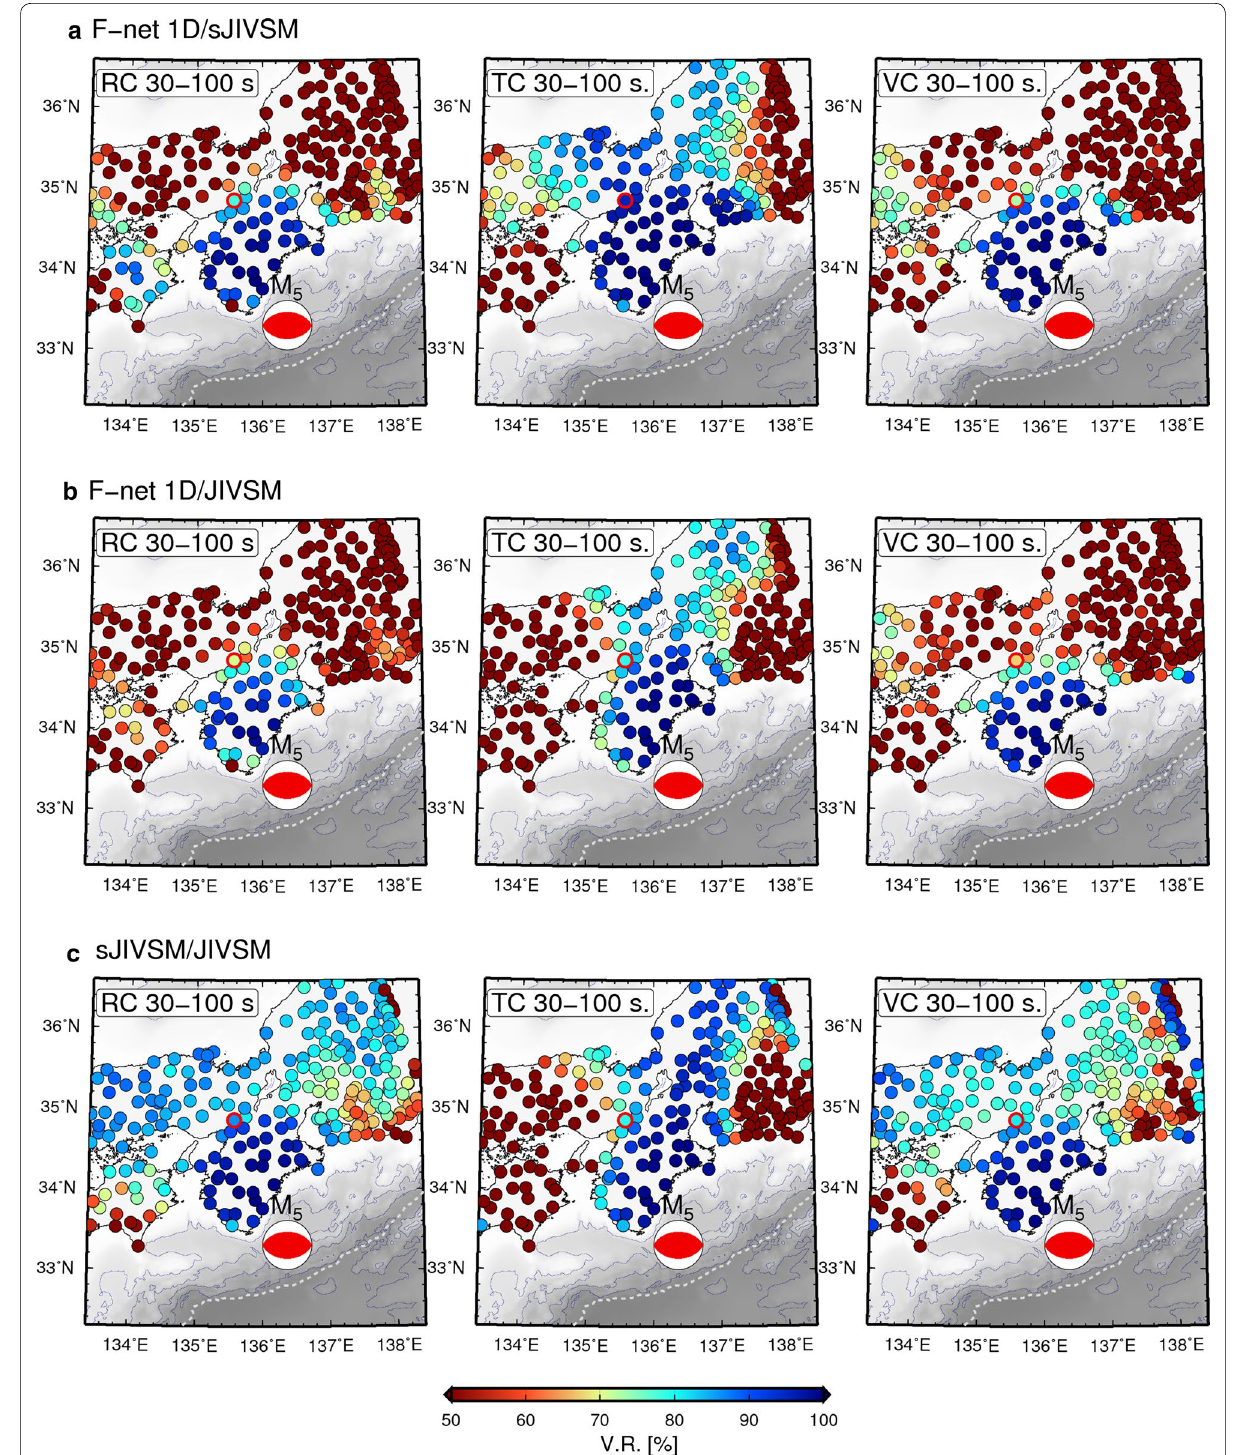
Fig. 5 Spatial distribution of waveform differences among Green’s functions for three model pairs. Waveform differences were evaluated by the variance reduction (V.R.) of Eq. (3). The assumed moment tensor is the pure dip slip ( M zz with periods of 30–100 s was applied to each trace. Red enclosed symbols indicate F-net